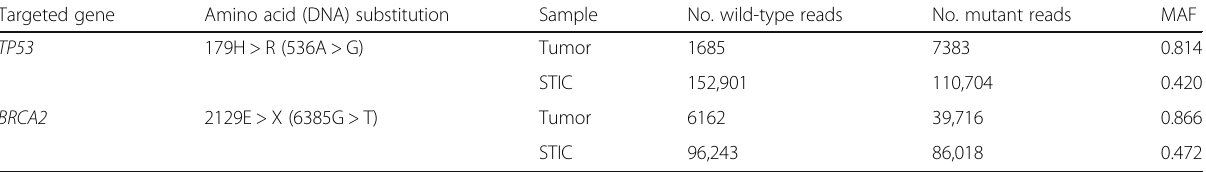
Table 2 Deep sequencing information of the tumor and STIC Targeted gene Amino acid (DNA) substitution